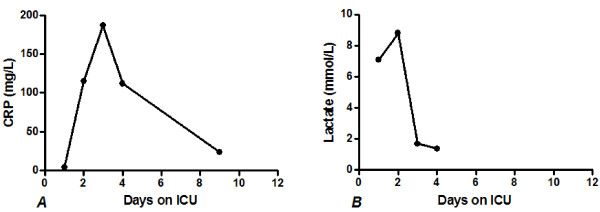
C-reactive protein and lactate concentrations over time of the second case. A C-reactive protein concentrations and B Lactate concentrations A C-reactive protein concentrations and B Lactate concentrations. After admittance into the ICU, the lactate levels increased till 10 mmol/L and thereafter decreased to normal values. The C-reactive protein levels follow the same pattern.